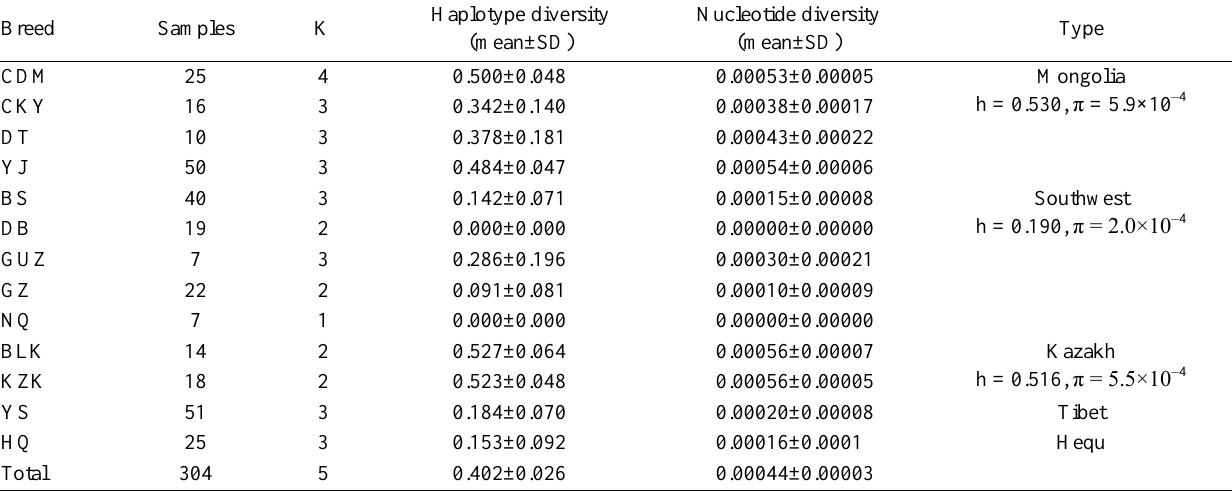
Table 6. Haplotype diversity and nucleotide diversity in 13 horse breeds Breed